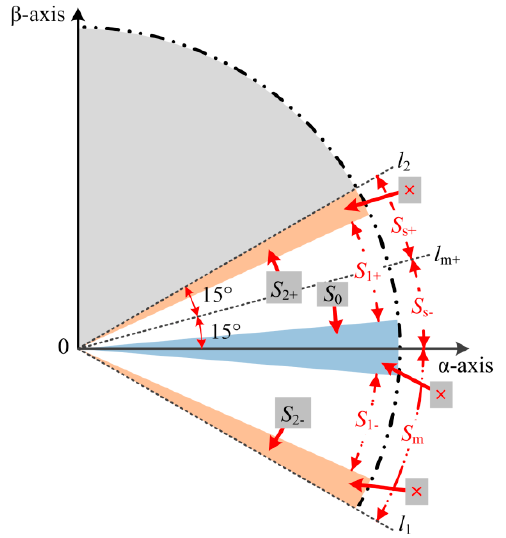
Figure 11. Relationships of the variables in the control system.